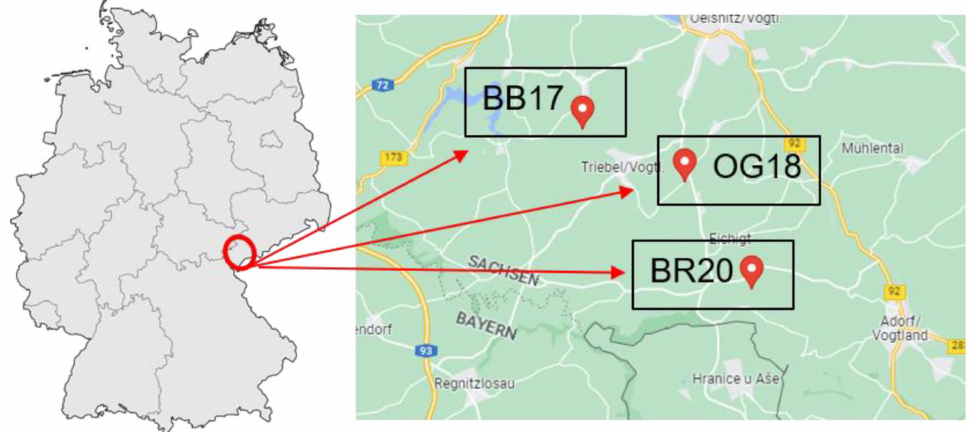
Figure 1. Study site map in the low mountains of Saxonian Vogtland, Germany and experimental fields Bösenbrunn (BB17), Oberhermsgrün 2018 (OG18) and Bergen (BR20). The preceding crops on BB17 and OG18 were winter oilseed rape ( Brassica napus L., 2015, conventional agricultural conditions and 2016, in conversion to organic conditions) and winter wheat ( Triticum aestivum L., 2016 and 2017, in conversion to organic conditions). At BR20, a red clover–grass mix ( Trifolium pratense L. and Lolium perenne L.) was used